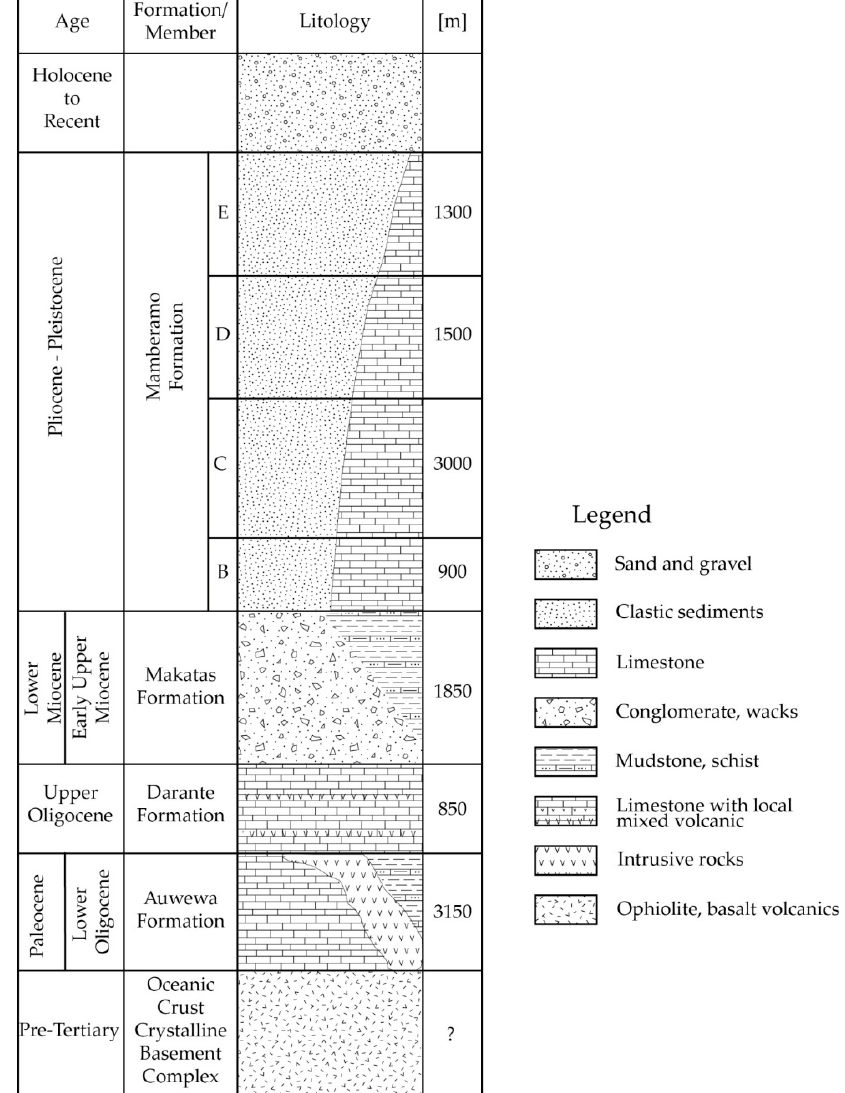
Figure 4. Geological profile of Waropen Basin’s sediments [33–35].